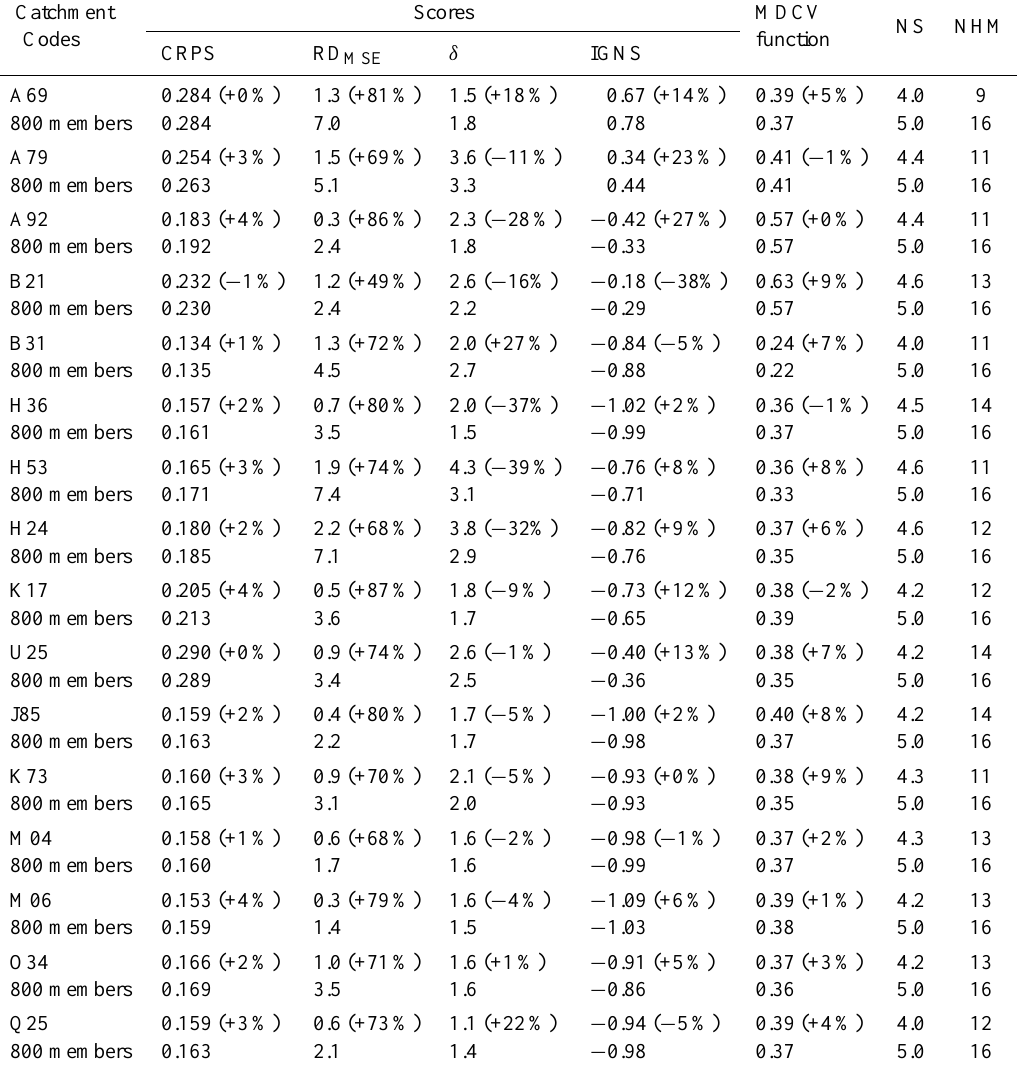
Table 2. Selection of 50 hydrological members based on combined criterion and the BGS-CV process on the 9-day FTH. Beside each score is presented the gain index evaluated by Eq. (2). NS represents the normalized sum (Eq. 1 with unit weights). NHM indicates the number of hydrological models participating in the selection. RD MSE values are expressed on a 10 − 3